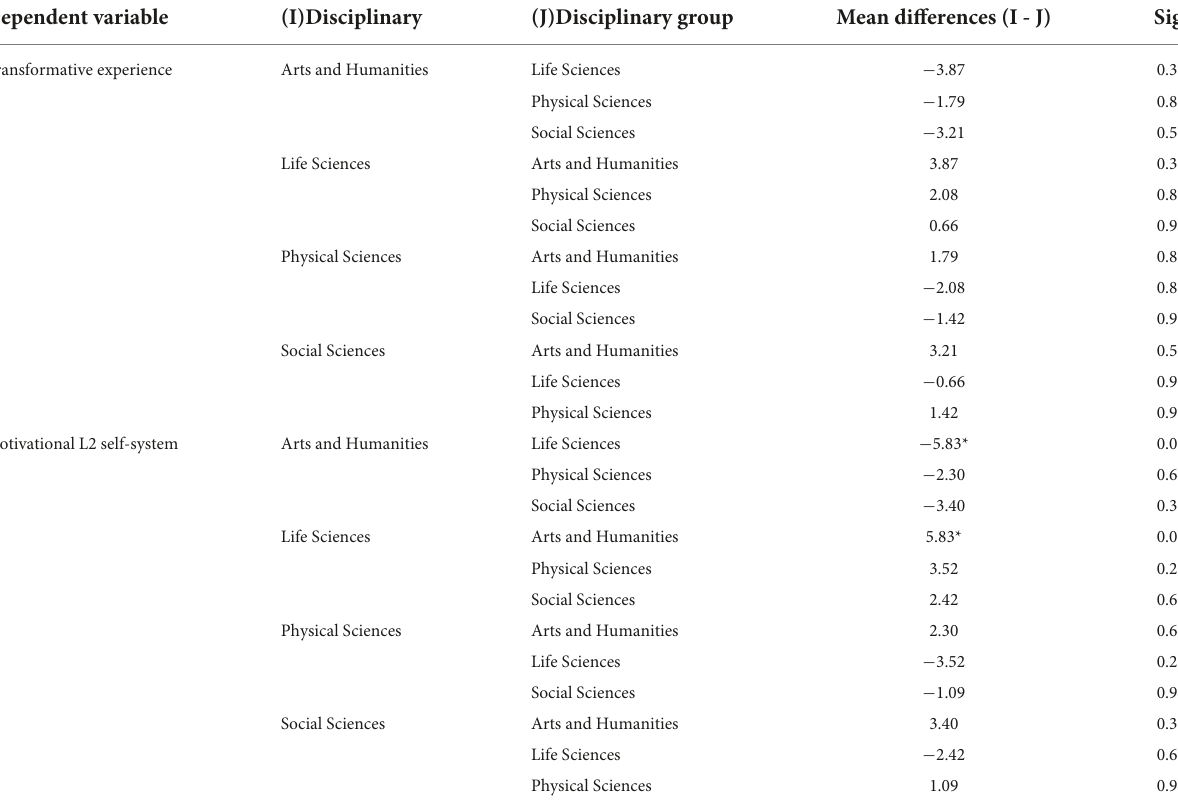
TABLE 8 Post hoc test (Tukey’s